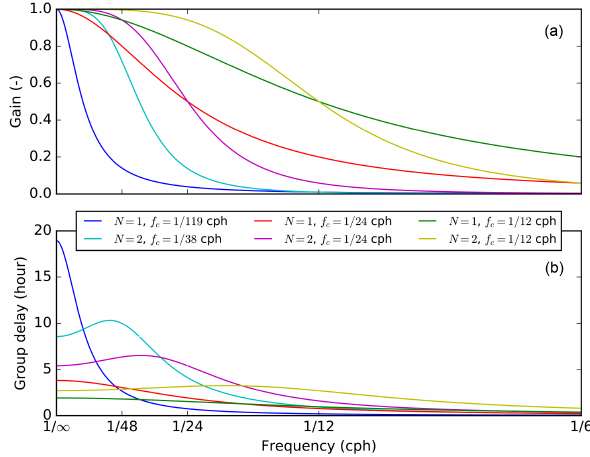
Figure 1. Filter responses of Butterworth filters of the first and second order for various cut-off frequencies. Top panel shows the power gain as a function of frequency, and the bottom panel shows the group delay as a function of